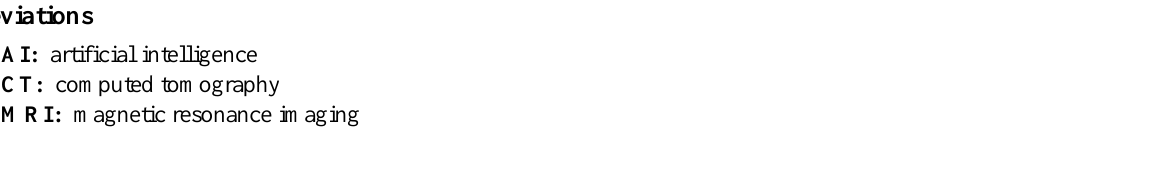
MRI: magnetic resonance